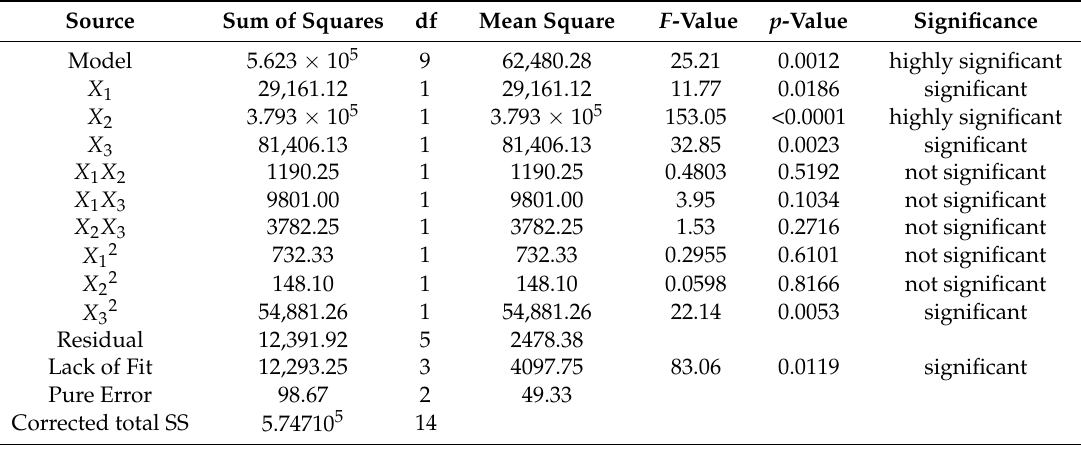
Table 4. ANOVA results for response variable R 2